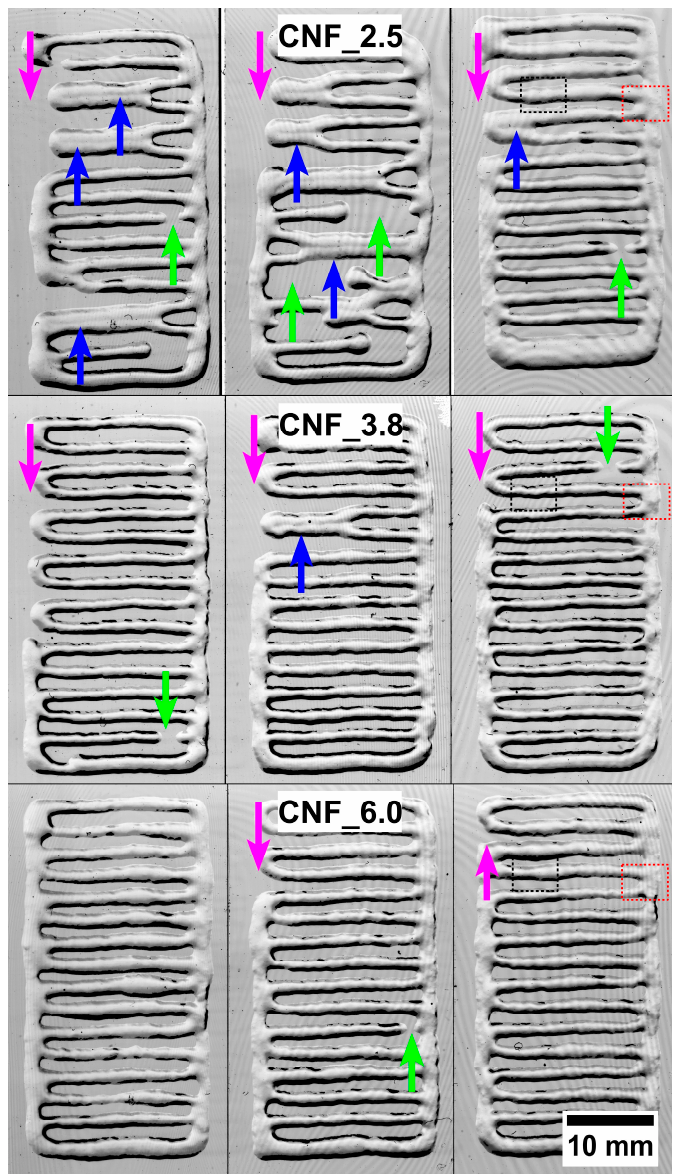
Figure 4. Evaluation of printability of the inks CNF_2.5, CNF_3.8, and CNF_6.0. The three columns provide three corresponding replicates for each series. The major defects were observed in structures printed with CNF_2.5, including missing edges (magenta arrows), the fusing of printed tracks (blue arrows), and empty spaces (green arrows). The target size of the printed structures was 20 × 40 mm in one layer. The black and red dotted rectangles on the right side indicate the areas for horizontal and vertical SEM analyses, respectively (Figure 5). The contrast of the images was improved for better visualization.